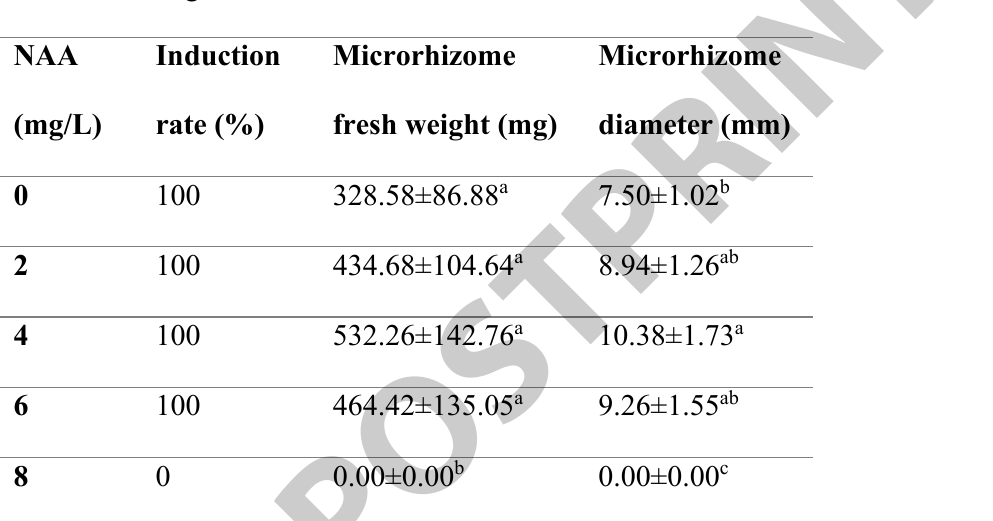
-naphthaleneacetic acid (NAA) concentrations on microrhizome Table 4. Impact of different 𝛼𝛼 induction and growth